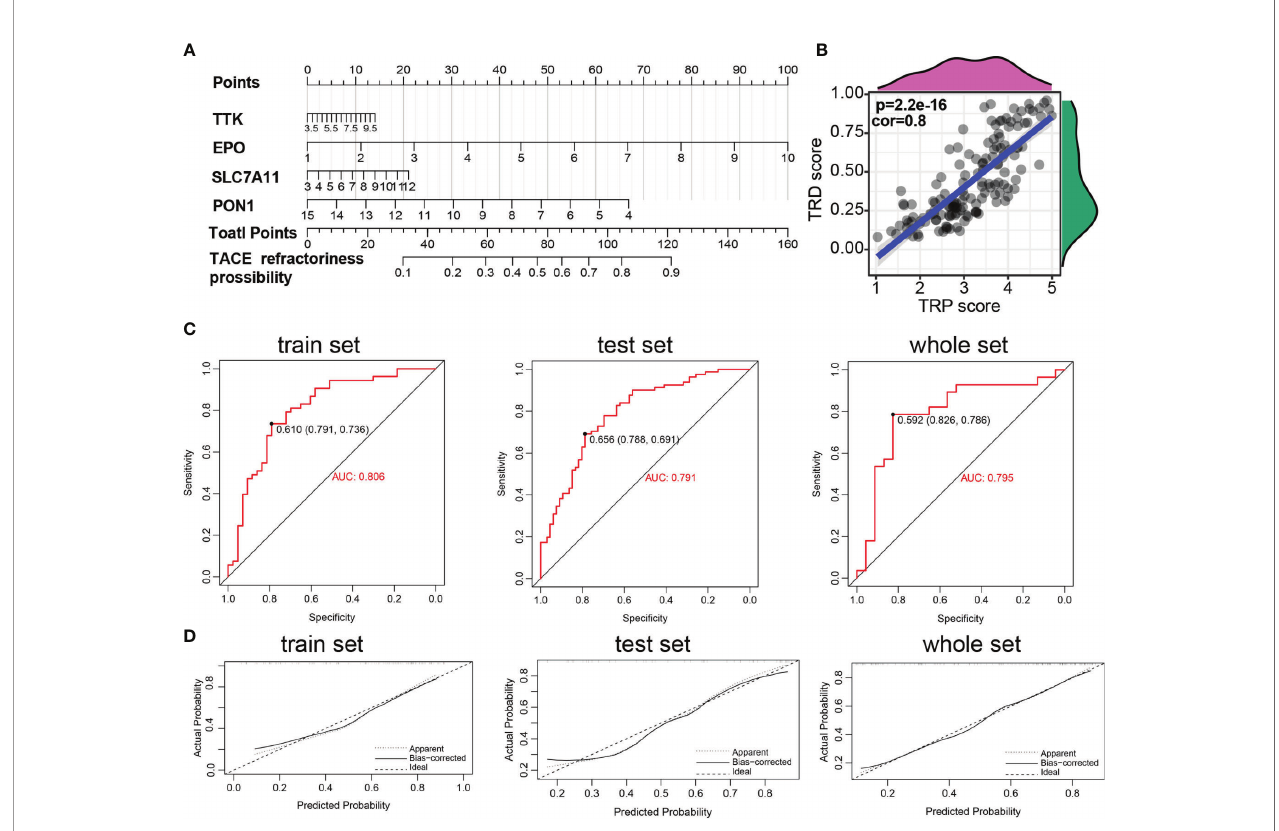
FIGURE 4 | Construction of TACE refractoriness – related diagnostic score (TRD score). (A) Nomogram predicting the probability of TACE refractoriness. (B) Correlation of TRP score and TRP score. (C) ROC curves of the nomogram. (D) Calibration curves of the